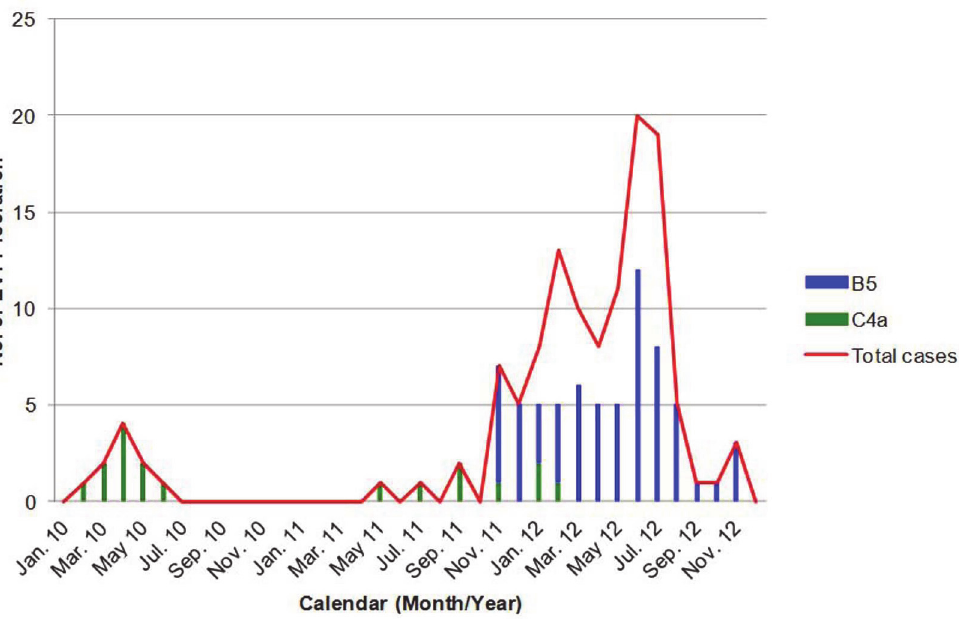
Fig 1. Distribution of enterovirus 71 (EV71) genotypes (B5 and C4a) isolated in pediatric inpatients in a medical center in northern Taiwan, 2010~2012.